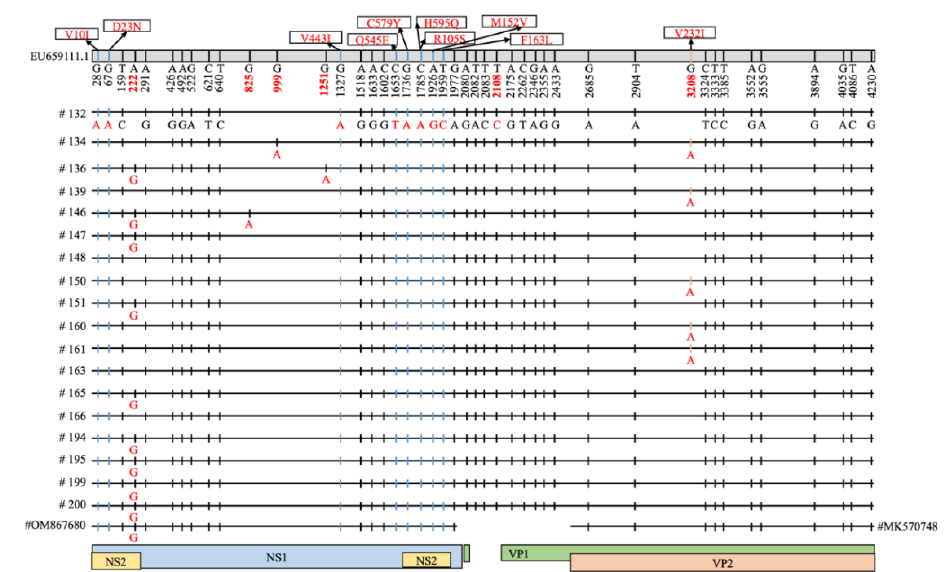
Figure 2. Mutations in the 18 FPV consensus sequences in this study and closely related VP2 (#MK570748) and NS1 (#OM867680) gene sequences in comparison with the FPV reference genome (EU659111). The nucleotide position is indicated in the bar at the top of the figure, together with changes in amino acid sequence, and the character state of individual nucleotides is indicated below for each consensus sequence. Synonymous mutations are indicated by black vertical bars, and nonsynonymous mutations are indicated by blue or orange vertical bars, corresponding to the relevant gene segment indicated at the bottom of the figure. Nucleotides of other sequences that are the same as for sample #132 are indicated by a vertical bar. A total of 10 nonsynonymous mutations (9 nucleotide positions were involved) were identified (NS1/NS2: Val10Ile, Asp23Asn; NS1: Val443Ile, Gln545Glu, Cys579Tyr, His595Gln; NS2: Arg105Ser, Met152Val, Phe163Leu; VP1/VP2: Val232Ile). The six nucleotide diversity positions (222, 825, 999, 1251, 2108, and 3208) are indicated by red font on the genome bar at the top of the